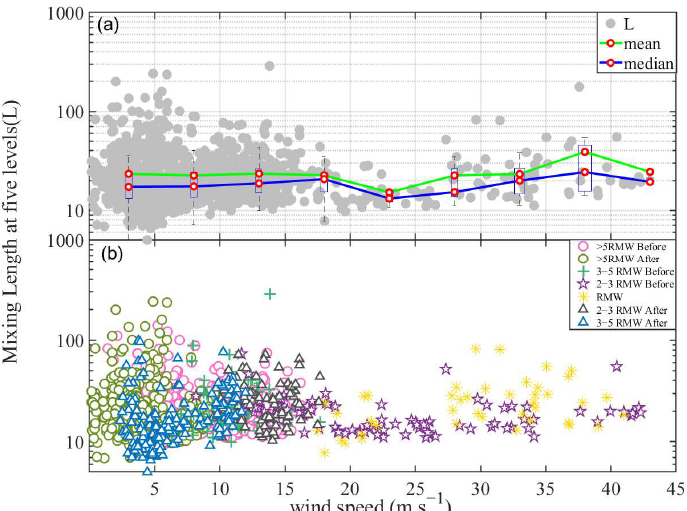
Figure 13. ( a ) Vertical mixing length ( L m ) as a function of wind speed ( u n ). The data were classified into seven categories according to their distance from the typhoon center. ( b ) The blue line with the red circles is the bin median average K t at 5 m s –1 intervals of u n from the observations. The green line with red circles is the bin mean average K t at 5 m s –1 intervals of u n from the observations. 3.7. Variations in the Strain Ratio The strain ratio ( S ) as a function of u n with the bin averaged mean and median lines of S are shown in Figure 14a. Meanwhile, the S at different layer with u n is shown in Figure